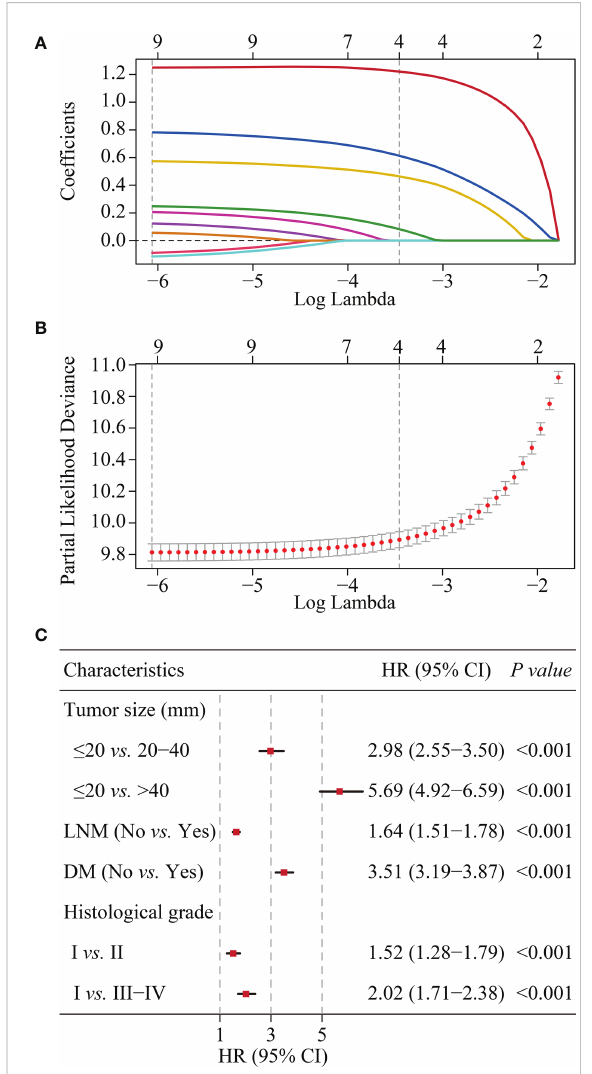
FIGURE 3 Predictor screening. (A) and (B) . The least absolute shrinkage and selection operator (LASSO) regression and 10-fold cross- validation for screening predictors. (C) . Multivariate Cox regression forest plot showing the effect of predictors on cancer-speci fi c survival (CSS) of cervical cancer. HR, hazard ratio; CI, con fi dence interval; LNM, lymph node metastasis; DM, distant metastasis.